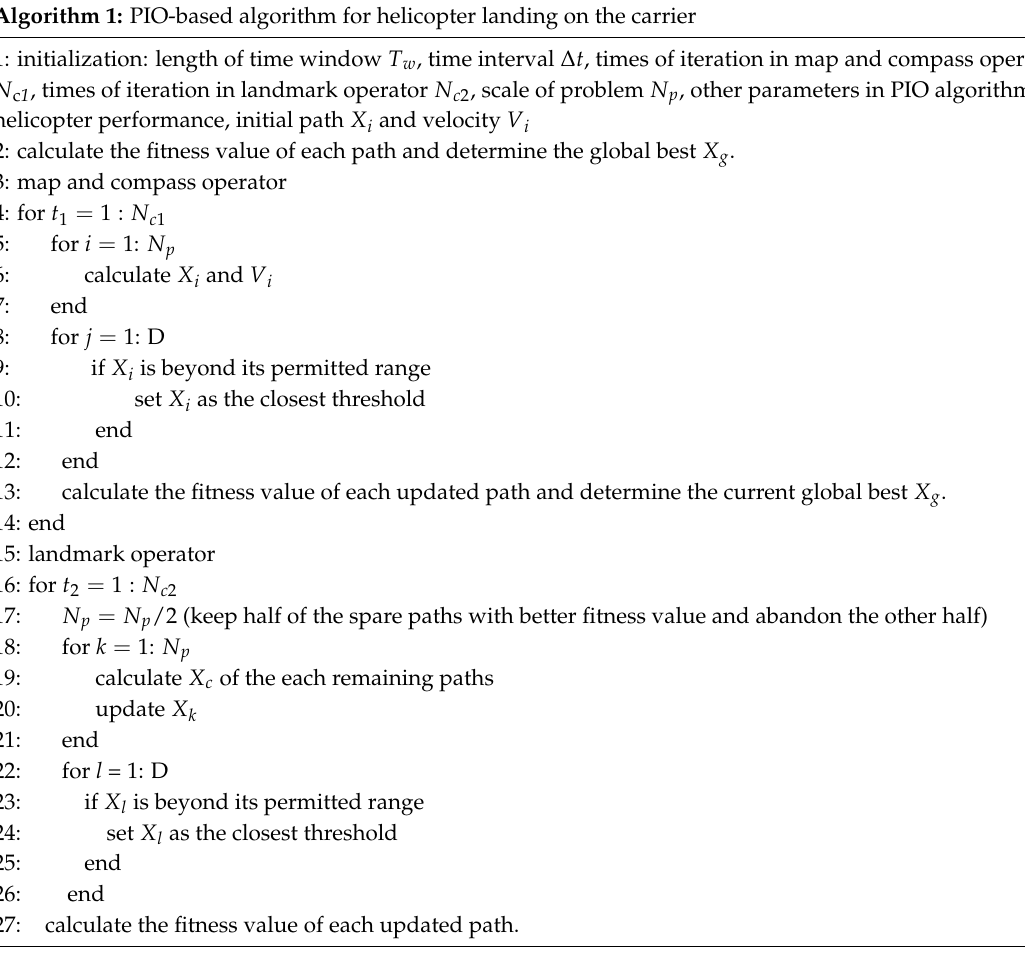
Algorithm 1: PIO-based algorithm for helicopter landing on the carrier 1: initialization: length of time window T w , time interval ∆𝑡 , times of iteration in map and compass operator N c 1 , times of iteration in landmark operator N c 2 , scale of problem N p , other parameters in PIO algorithm, helicopter performance, initial path X i and velocity V i